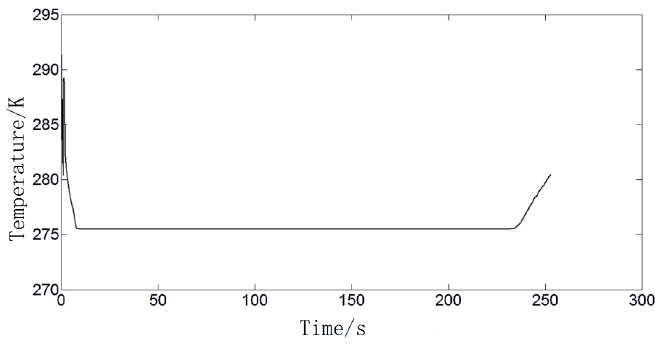
Figure 6. Temperature variation curve of the outlet water.